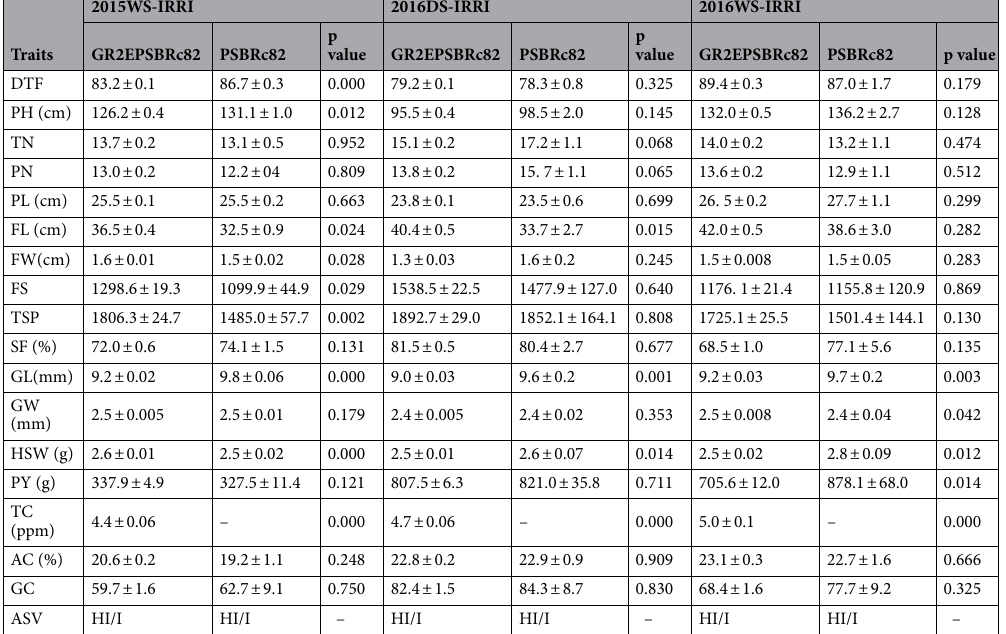
Table 1. Agronomic and grain quality performance of GR2EPSBRc82 at IRRI. DTF days to fifty percent flowering, PH plant height, TN Tiller number, PN Panicle number, PL Panicle length, FL flag leaf length, FW flag leaf width, FS number of filled spikelets, TSP total number of spikelets per plant, SF spikelet fertility, GL grain length, GW grain width, HSW hundred seed weight, PY plot yield, TC total carotenoids, AC amylose content, GC gel consistency, ASV alkali spreading value.